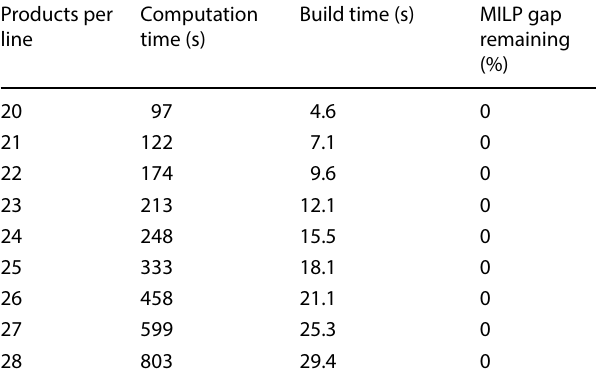
Table 5 Performance for separate production line optimization Products per line